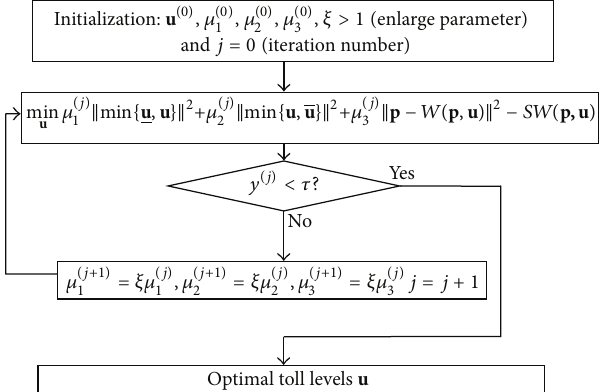
Figure 1: The flowchart of the proposed solution algorithm.